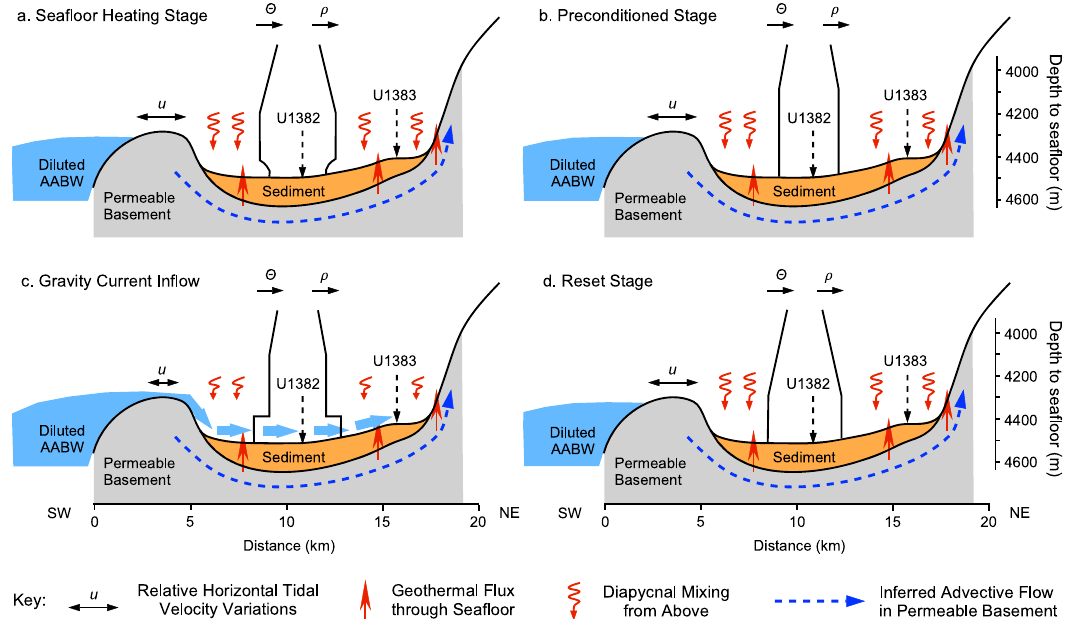
Fig. 5 Cartoon representing four stages of our conceptual model for renewal of North Pond bottom waters. The model involves slow heating of bottom waters by the geothermal fl ux and diapycnal mixing, setting the stage for cold water intrusions inferred to be from the leading edge of diluted AABW fl owing over the deepest sill on the southwest side of North Pond. Plots labeled Θ and ρ represent idealized pro fi les of Conservative Temperature and density at each stage. Their scales and structures are schematic and intended only to illustrate relative changes in properties with depth. As shown in the bottom key, horizontal two-sided arrows represent relative horizontal tidal velocity variations, red upward arrows represent geothermal heating, red squiggly arrows represent heat input by diapyncal mixing, and dashed blue lines represent inferred low-temperature advective fl ow within permeable basement. a Heating of bottom waters below sill depth by the geothermal fl ux through the sea fl oor and by diapycnal mixing in the water column. The curvatures in the pro fi les in the deepest geothermally heated boundary layer are drawn to be consistent with comparable bottom boundary layers documented in Cascadia Basin 4 . b Preconditioned stage reached when the vertical extent of the heated bottom waters reaches sill depth, or slightly shallower. c Gravity current in fl ow stage, when the horizontal tidal velocities over the sill are weak, and colder, denser diluted AABW replaces the deepest bottom water in the basin. d Reset stage after the intrusion of diluted AABW and vertical mixing have reestablished near uniform water temperature to sill